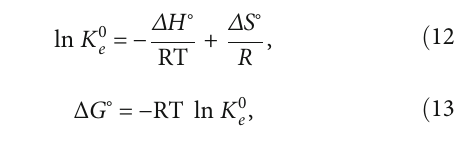
Figure 7: Mechanism adsorption of Cd(II) onto Fe